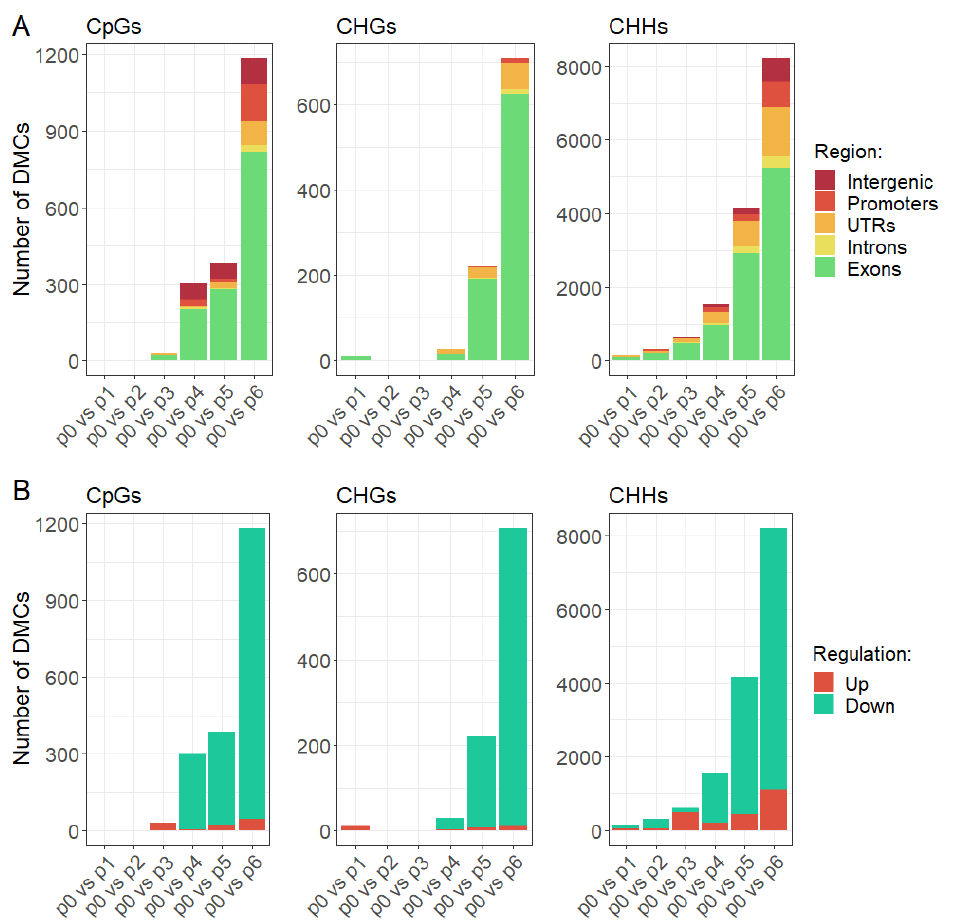
Figure 2. Differentially methylated cytosines in CpGs, CHGs, and CHHs in subsequent time points in comparison to control sample depending on genomic region ( A ) and direction of change ( B ).